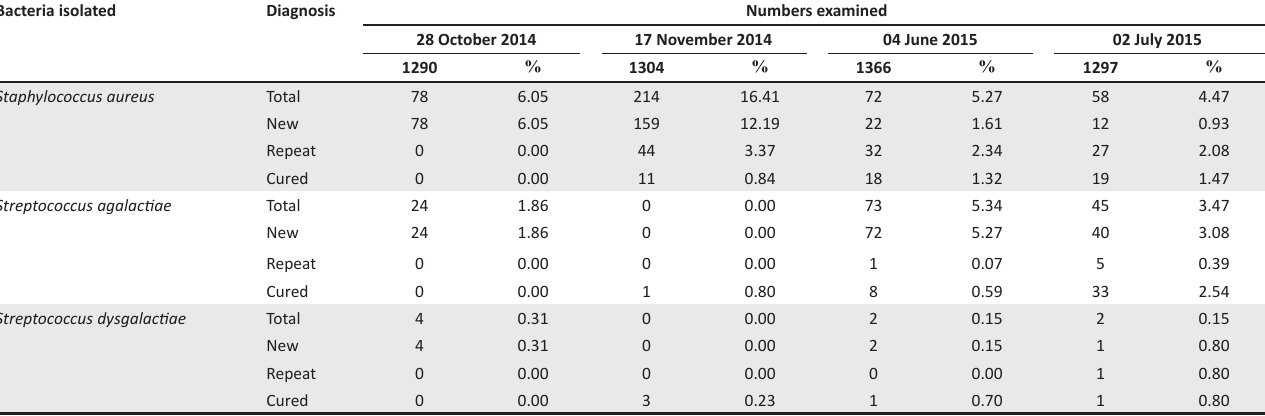
TABLE 1: Serial Herd Udder Health Report. Case study Part 1: Bacteriology history report for four consecutive herd examinations of the same herd using composite cow milk samples. Bacteria isolated Diagnosis Numbers examined